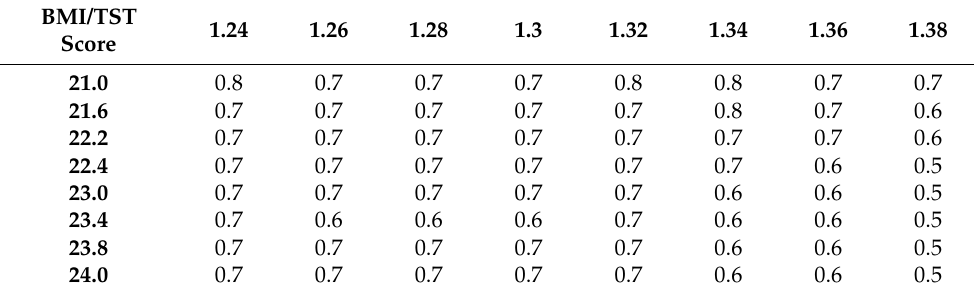
Table 7. Calculations of negative likelihood ratios for combinations of body mass index and two- step